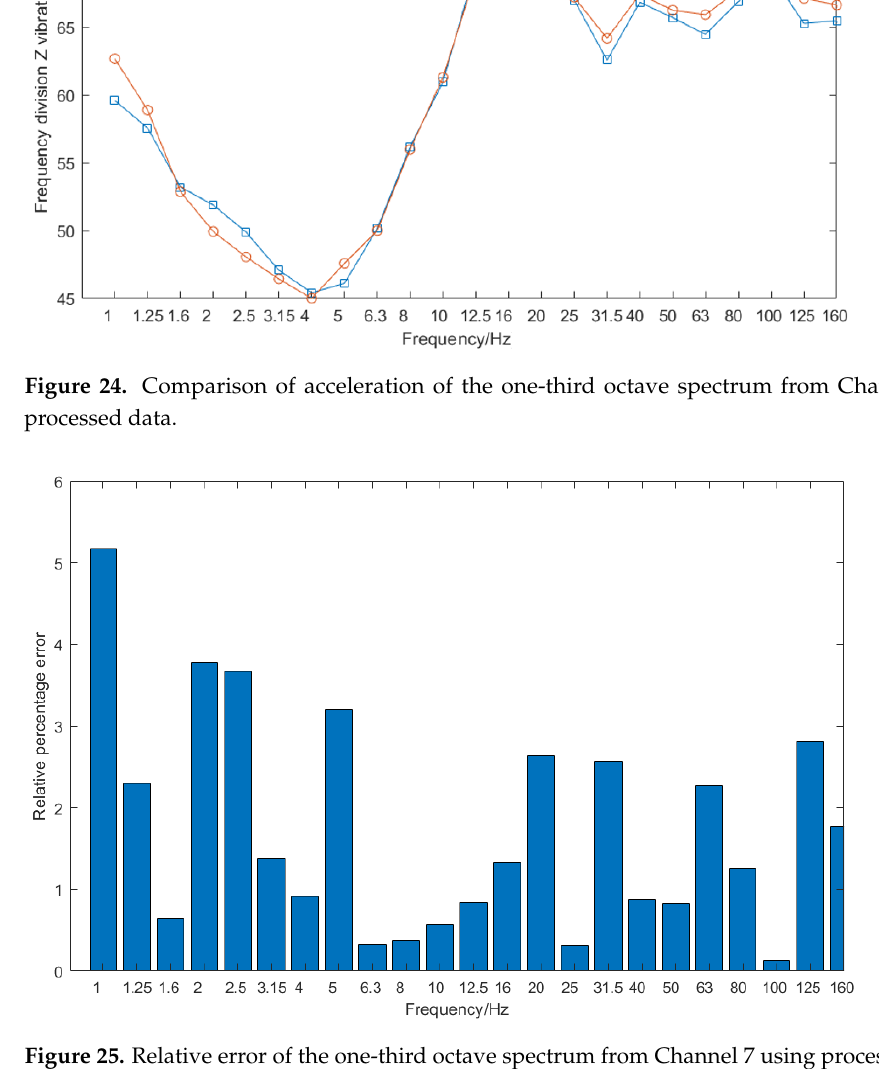
Figure 25. Relative error of the one-third octave spectrum from Channel 7 using processed data.